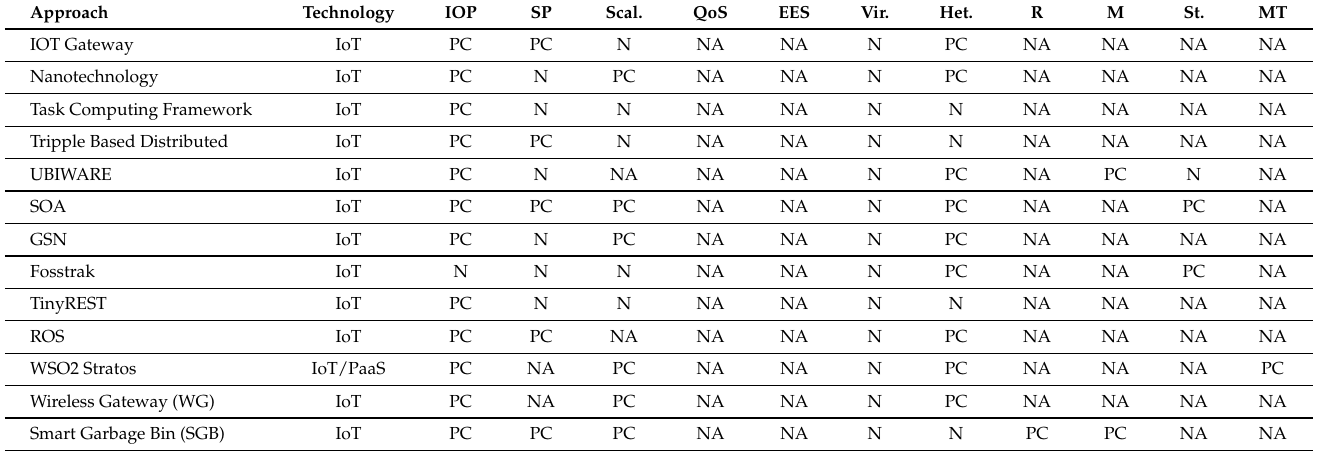
Table 1. Traditional IoT